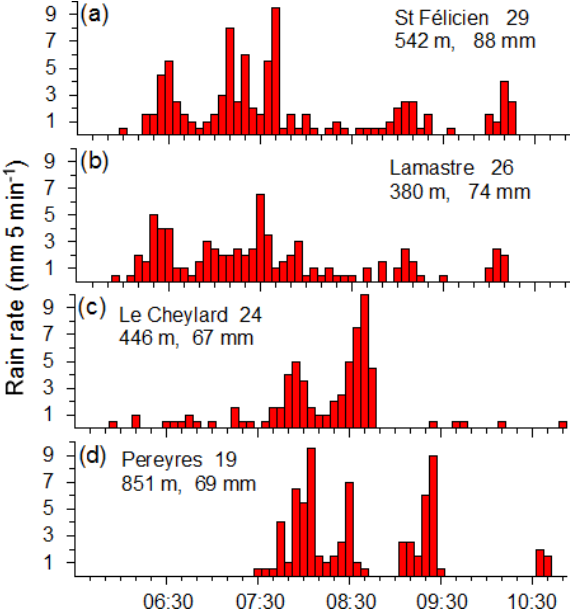
Figure 10. Temporal evolution of the 5 min rain rates of four obser- vational points in Vivarais for 26 September 2012. Numbers behind the names give their location, as indicated in Fig. 3, as well as the elevation above sea level and the accumulated rain